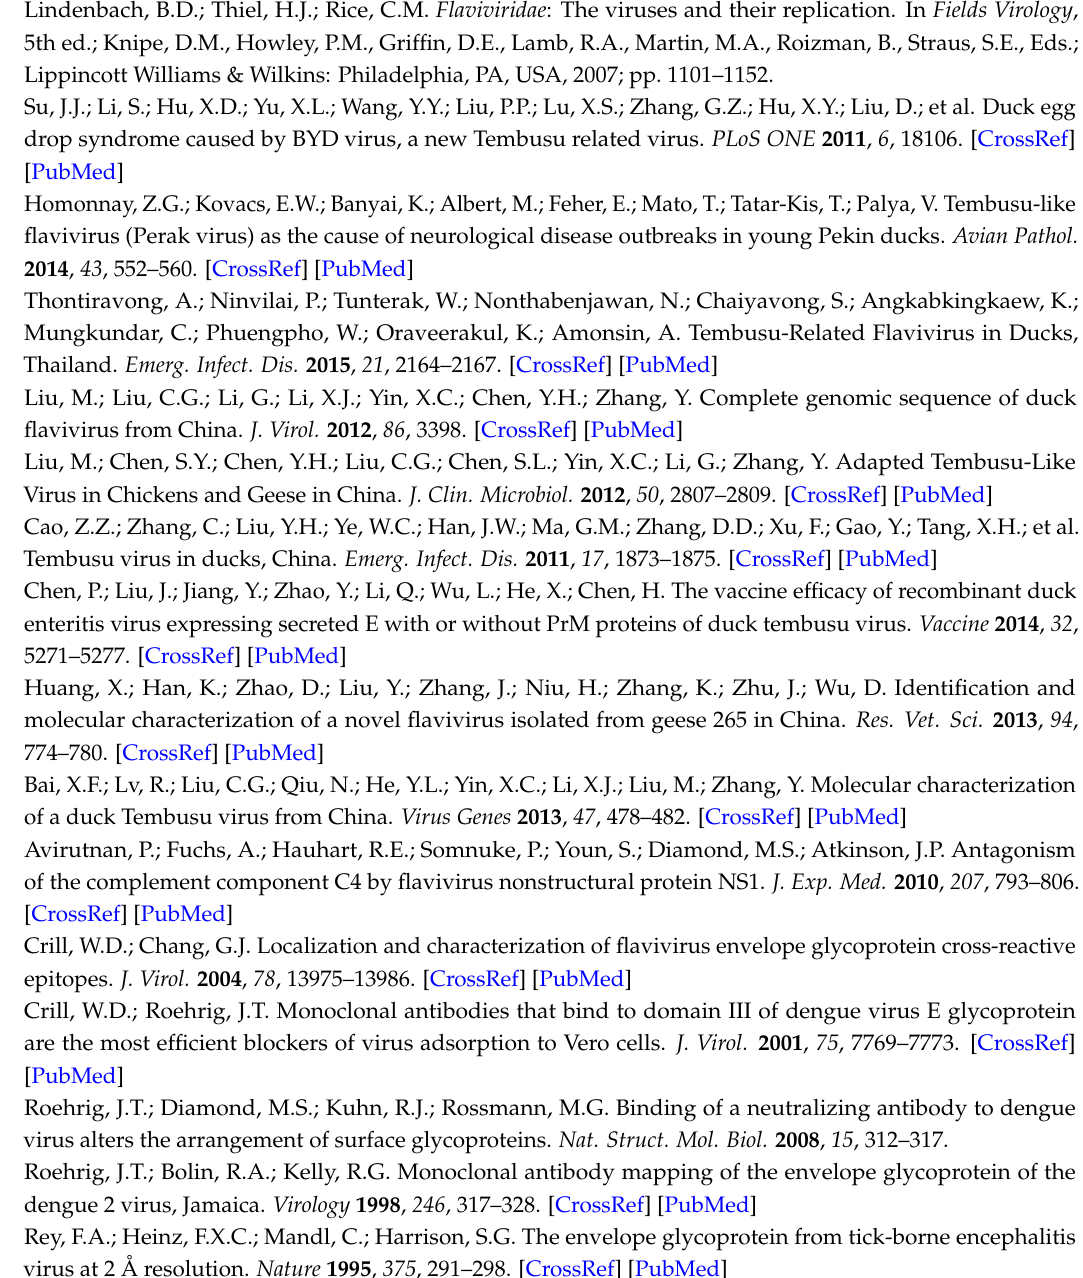
Figure S1: The stereochemical quality of the structure evaluated by ProSA and